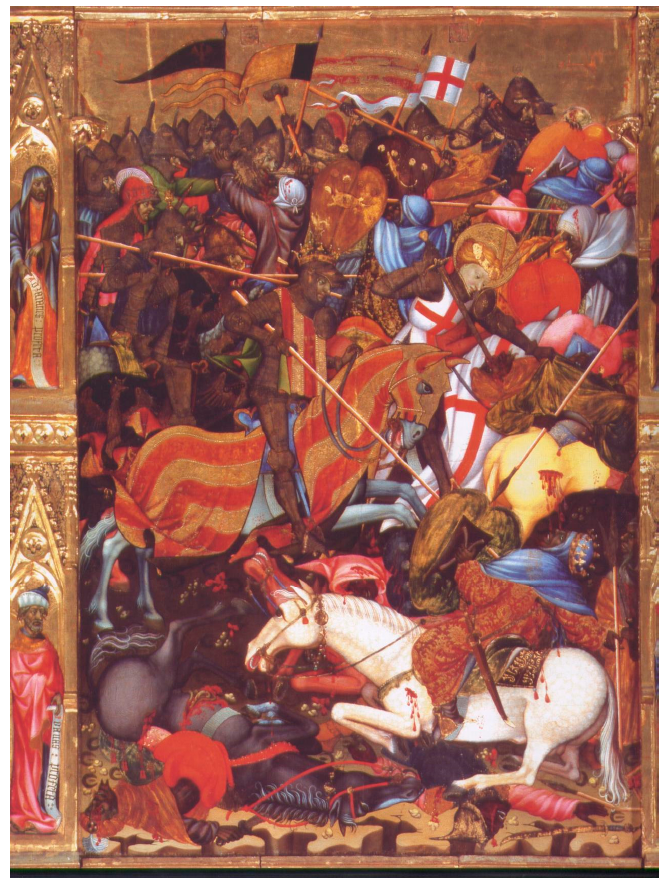
Figure 1. Battle scene from the Altarpiece of Saint George, Valencia. London, Victoria and Albert Museum, 1217–1864. Used by permission. Museum, 1217–1864. Used by